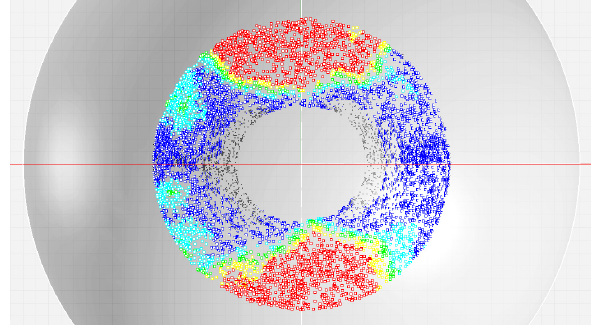
Figure 5. Gradation of distances from the points of the survey- model to the ideal model on top of the dome.